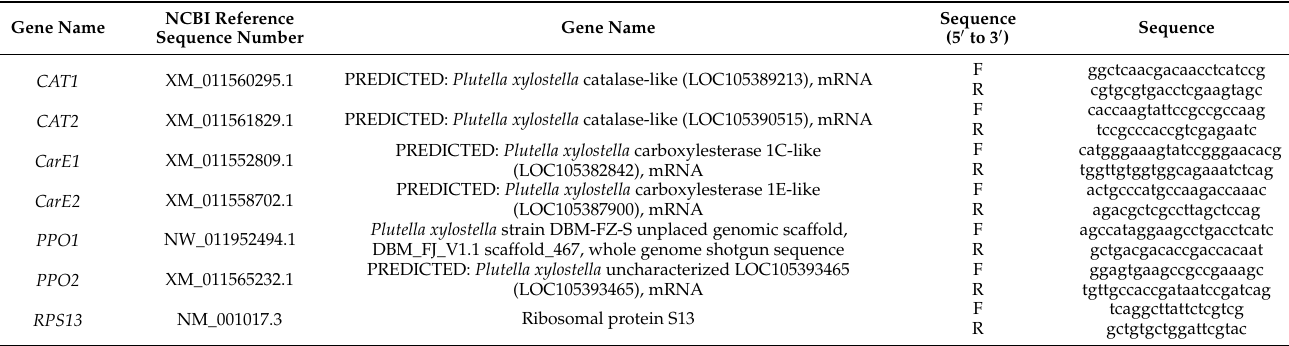
Table 1. The list of genes and primers of genes used on